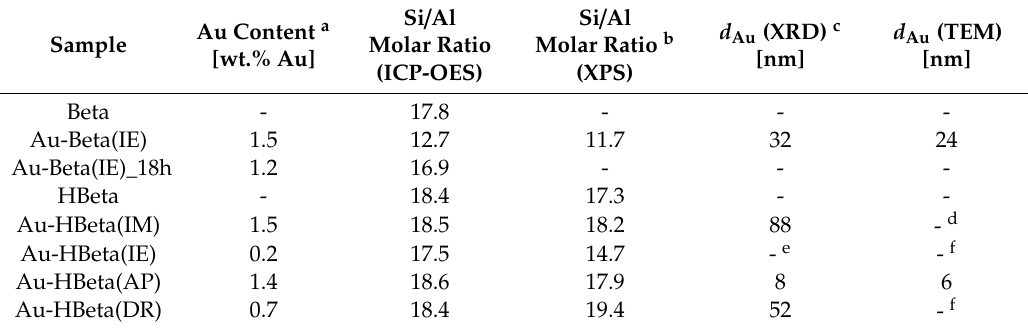
Table 1. Characteristics of materials used in this